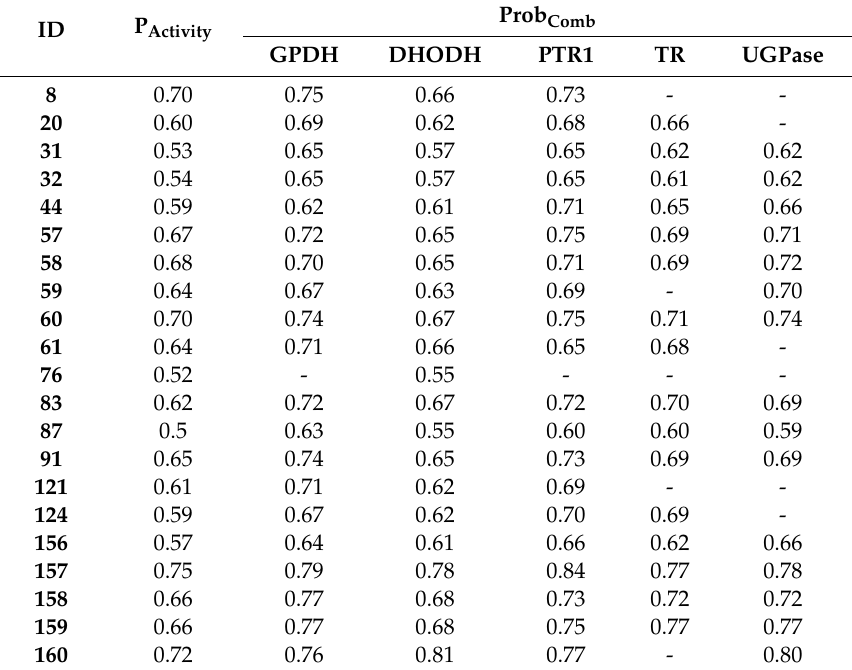
Table 8. Combined probabilities between prediction models and molecular docking analysis for potential activity against L. braziliensis